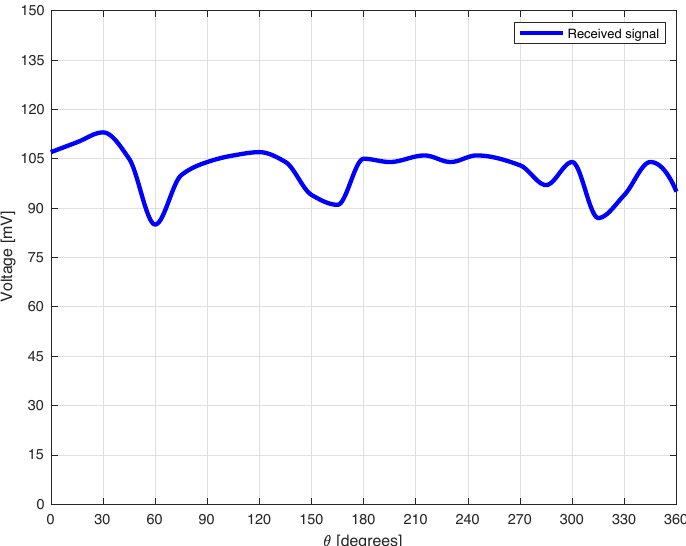
Figure 11. Assessment of the tag received signal vs. tag orientation. Measured signal vs. tag